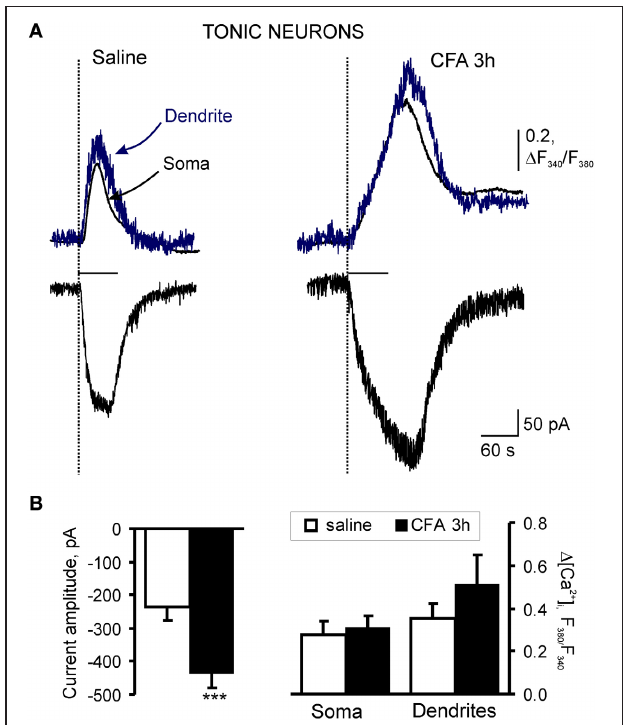
FIGURE 4 | Extrasynaptic AMPARs are markedly upregulated in tonic SG neurons during development of CFA-induced inflammatory pain. (A) Representative examples of AMPA-induced membrane current (bottom traces) and associated [Ca 2 + ] i transients in soma (upper black traces) and dendrites (upper blue traces) in tonic neurons 3h after saline (left traces) or CFA injection (right traces). (B) A statistical summary of current amplitudes (left graph) and [Ca 2 + ] i transients (right graph) in soma and dendrites of tonic SG neurons 3h after saline or CFA injection. AMPA-induced currents were significantly increased during chronic pain development. Despite the tendency toward an increase in [Ca 2 + ] i transients in SG neurons 3h after CFA injection, no significant change in their amplitudes was observed. ∗∗∗ p < 0 . 001 versus the saline-treated